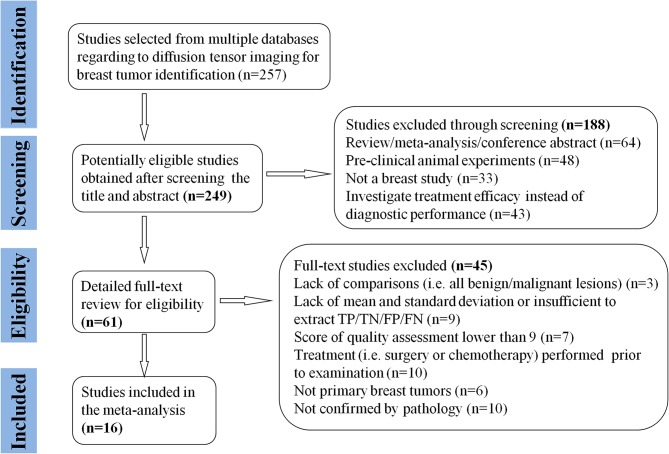
Flowchart of selection and exclusion process. Sixteen studies that met the inclusion criteria are eventually included. FN, false negative; FP, false positive; TN, true negative; TP, true positive.